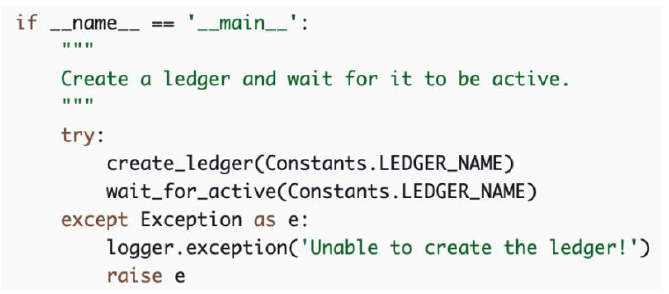
Figure 6. Creating the ledger using AWS ( Amazon Web Services), SDK (Software Development Kit ) for Python.